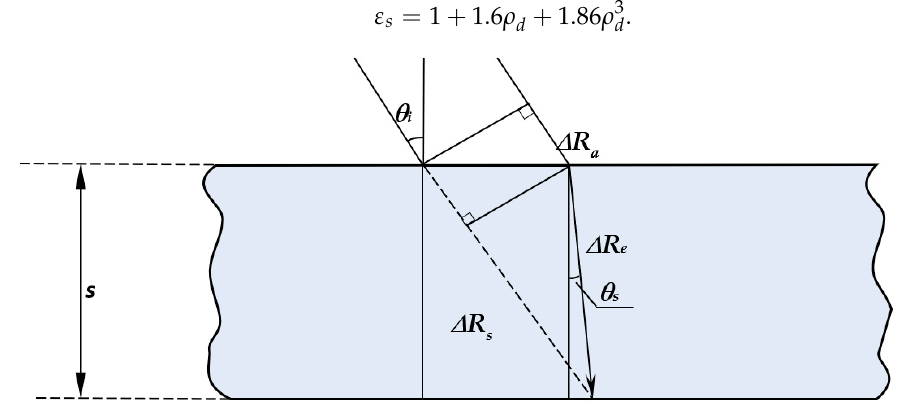
Figure 4. Signal propagation through the snow layer on the flat surface.